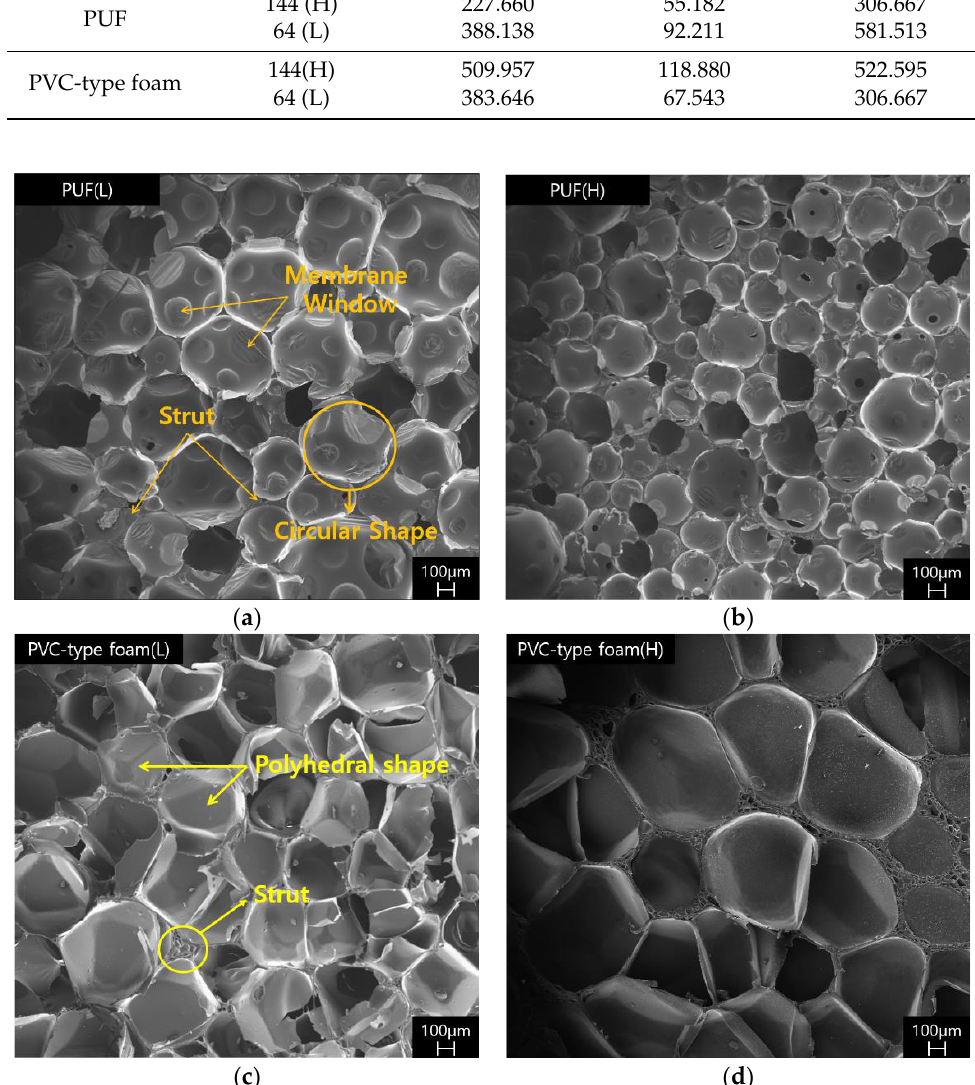
Figure 4. SEM images of microstructures: ( a , b ) PUF (L, H) and ( c , d ) PVC-type foam (L, H).